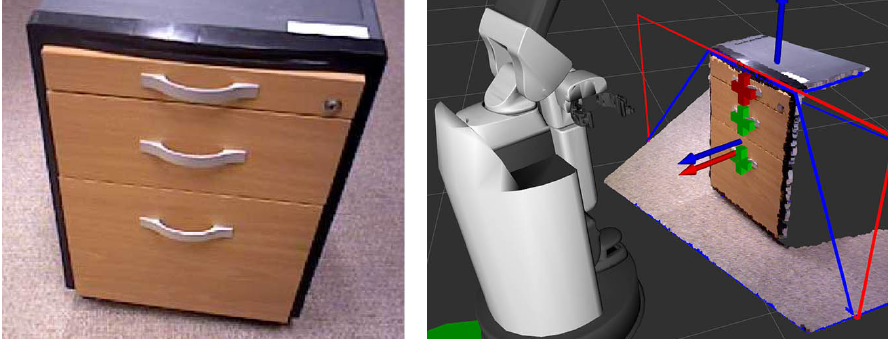
Figure 7. Handle detection